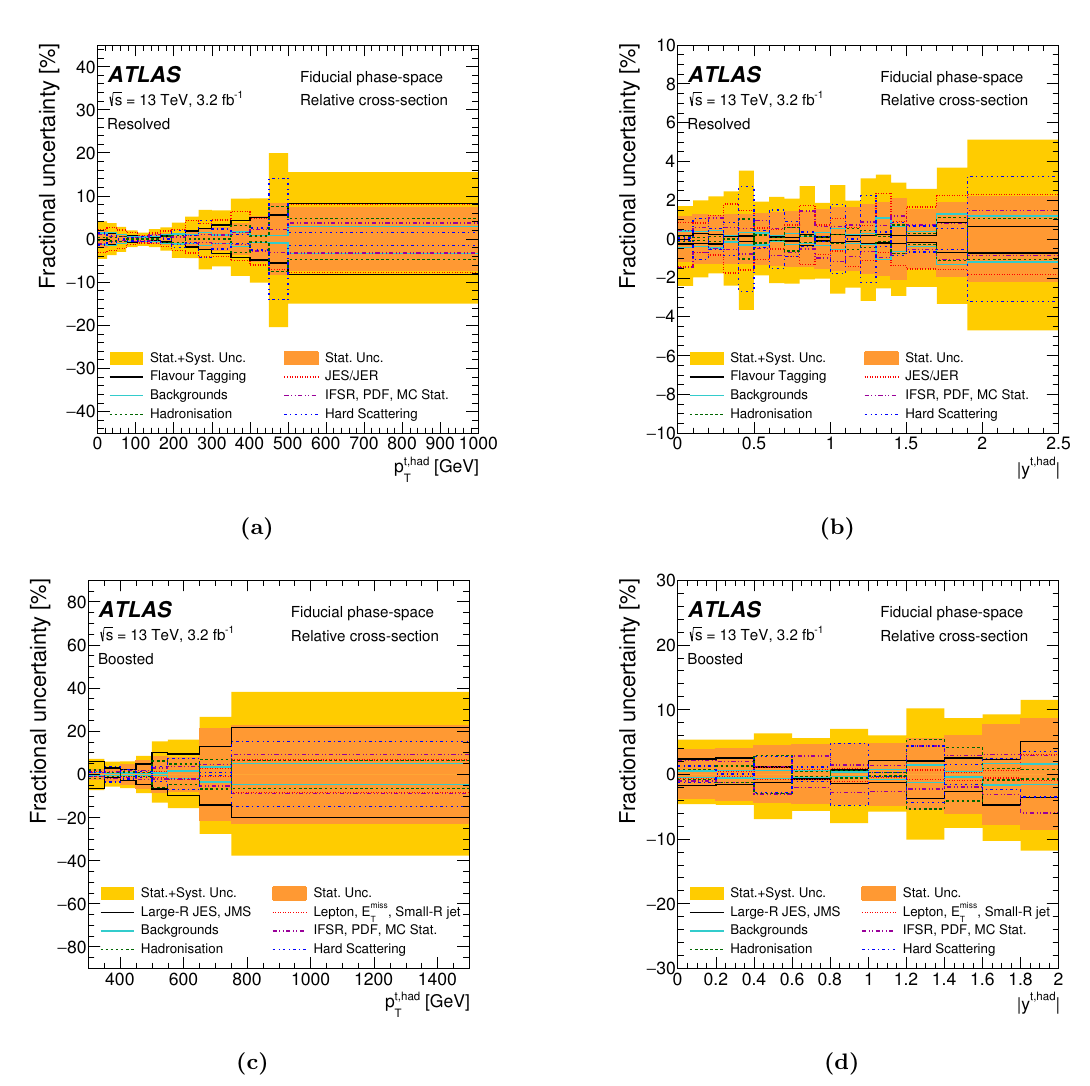
(cid:12) (cid:12) (cid:12) y t; had (cid:12) )